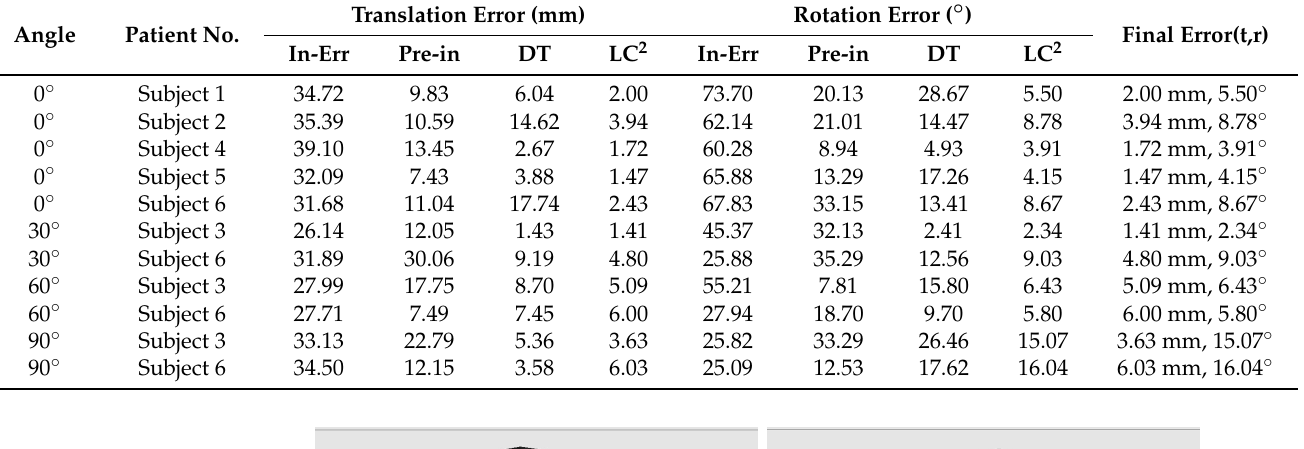
Table 2. Table showing a decreasing trend in the translation and rotation error (left to right) for each subject computed after each step of the proposed registration algorithm. In-Err: Initial error, Pre-in: Error after pre-initialization, DT: Error after applying Distance Transform, LC 2 : error after